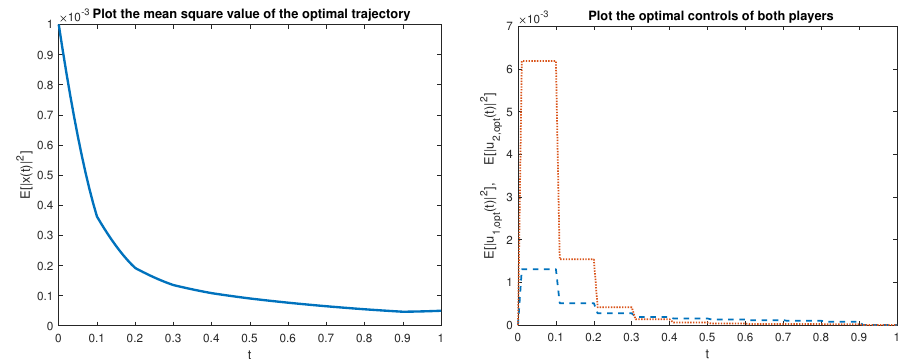
Figure 1. ( left ) E [ | ˜ x ( t ) | 2 ] ; Interval [ t 0 , τ ] = [ 0,1 ] ; ( right ) E [ | u 1, opt ( t ) | 2 ] and E [ | u 2, opt ( t ) | 2 ] ; Interval [ t ] = [ 0,1 ] . 0 , τ